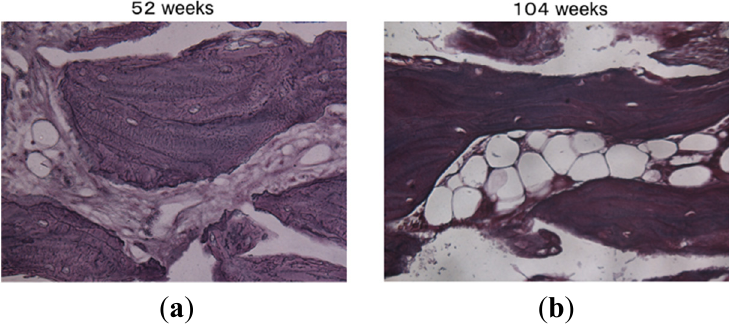
Figure 6. Cathepsin K immunostaining of osteoclast was performed at 52 weeks ( a ) and 104 weeks ( b ) after transplantation of UDPHAp. Cathepsin K-posive multinuclear cells (yellow arrow head) were predominantly located in medullae at 52 weeks.